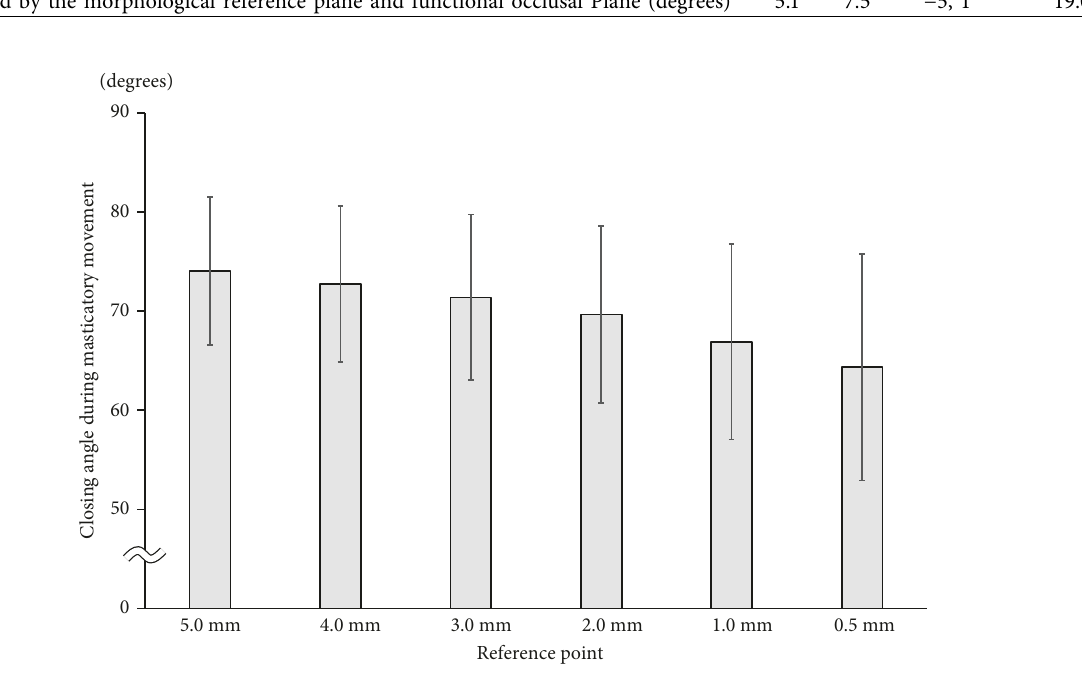
Figure 2: The closing angle during masticatory movement and tapping movement. (a) Six points were set on the trajectory of masticatory jaw movement, 5.0mm, 4.0mm, 3.0mm, 2.0mm, 1.0mm, and 0.5mm. Four points were set on the trajectory of tapping jaw movement, 2.0mm, 1.5mm, 1.0mm, and 0.5mm.(b) Closing angle at the 5.0-mm point. Table 1: Angle formed by the morphological reference plane and maxillary occlusal plane. Mean Sd Minimum Maximum Angle formed by the morphological reference plane and functional occlusal Plane (degrees) 5.1 7.5 − 5, 1 19.0